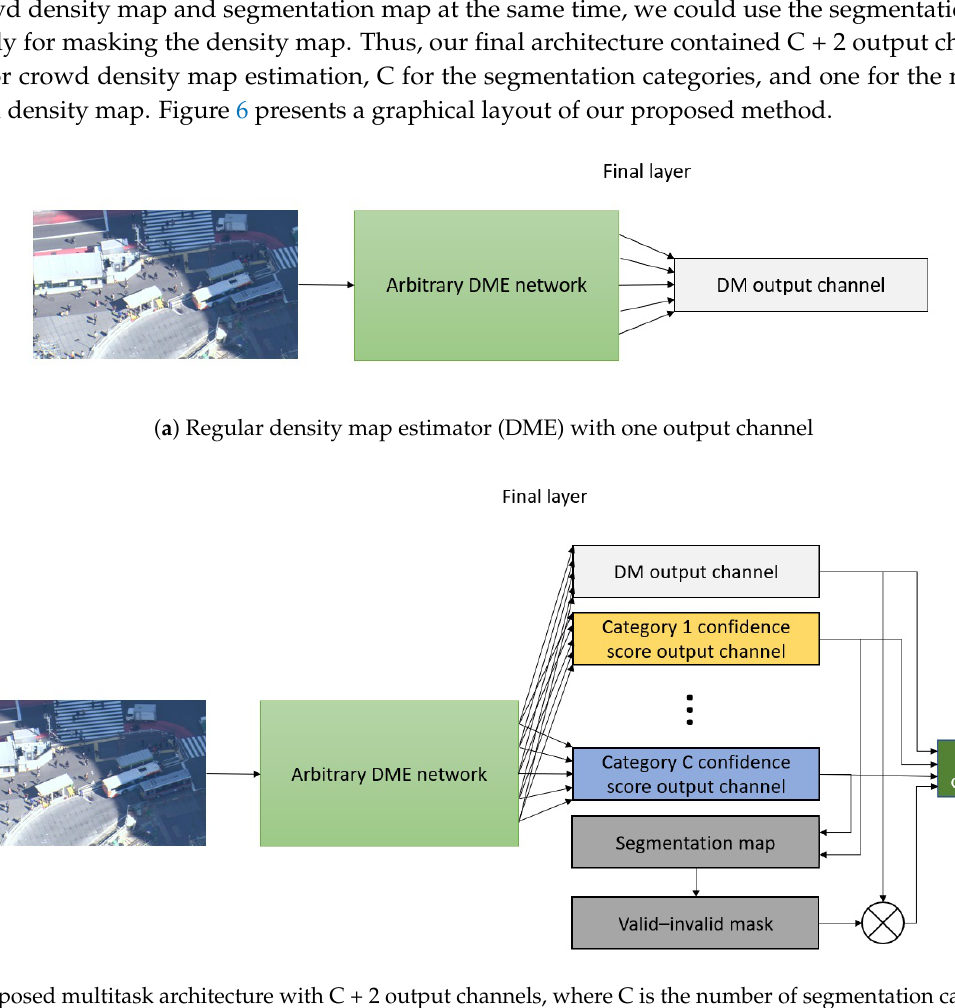
Figure 6. Visual representation of difference between regular DME network and our proposed multitask segmentation